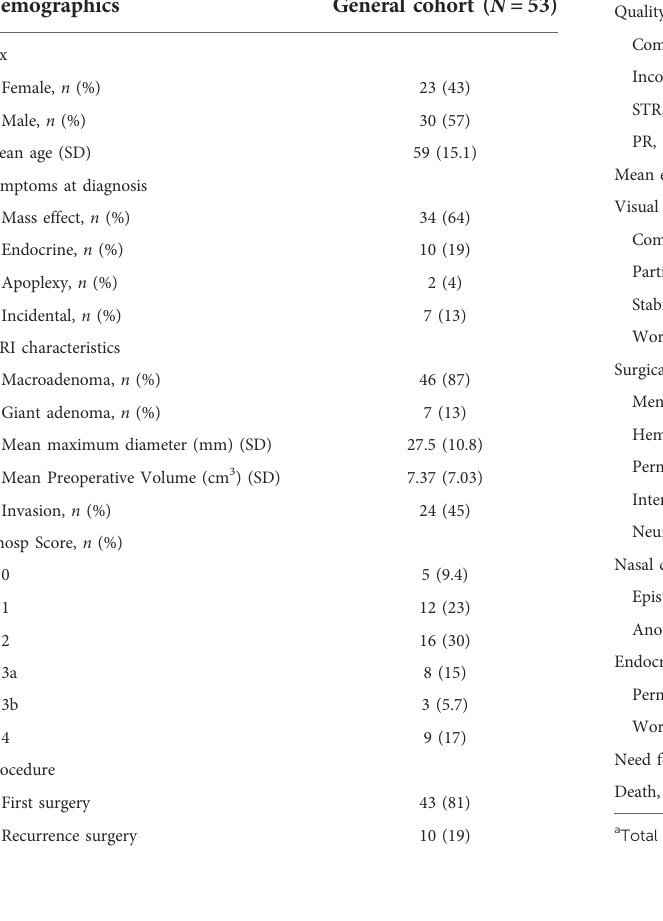
TABLE 1 Demographics and tumor type.